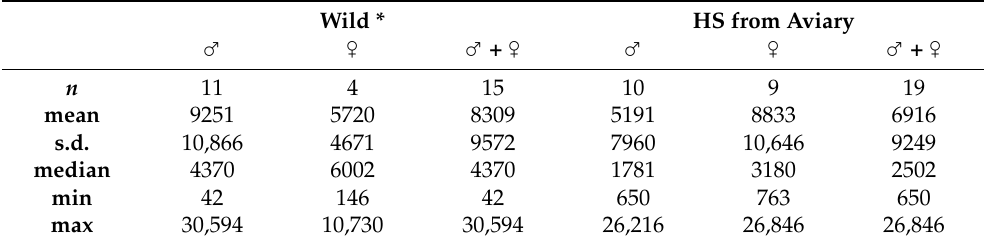
Table 4. Distances from origin to the first own nest (post-natal dispersal) in m. Wild * HS from